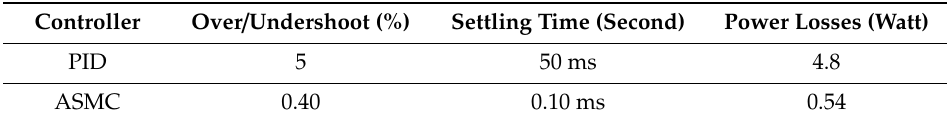
Table 6. Performance characteristics of the conventional controller and the proposed ASMC controller based in IPSM with 10 models.